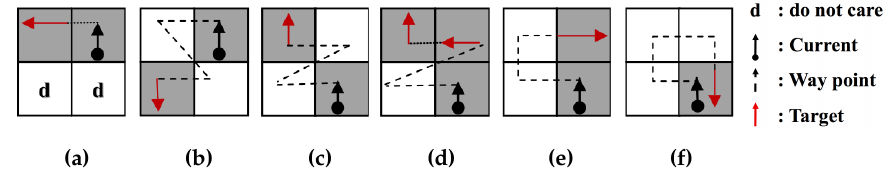
Figure 4. Contour cases of the improved SBF (ISBF) [16]: ( a ) left neighbor; ( b ) inner-outer corner at the left-rear; ( c ) inner-outer corner at the front-left; ( d ) inner corner at the front; ( e ) front neighbor; ( f ) outer corner. Reproduced with permission from [16].